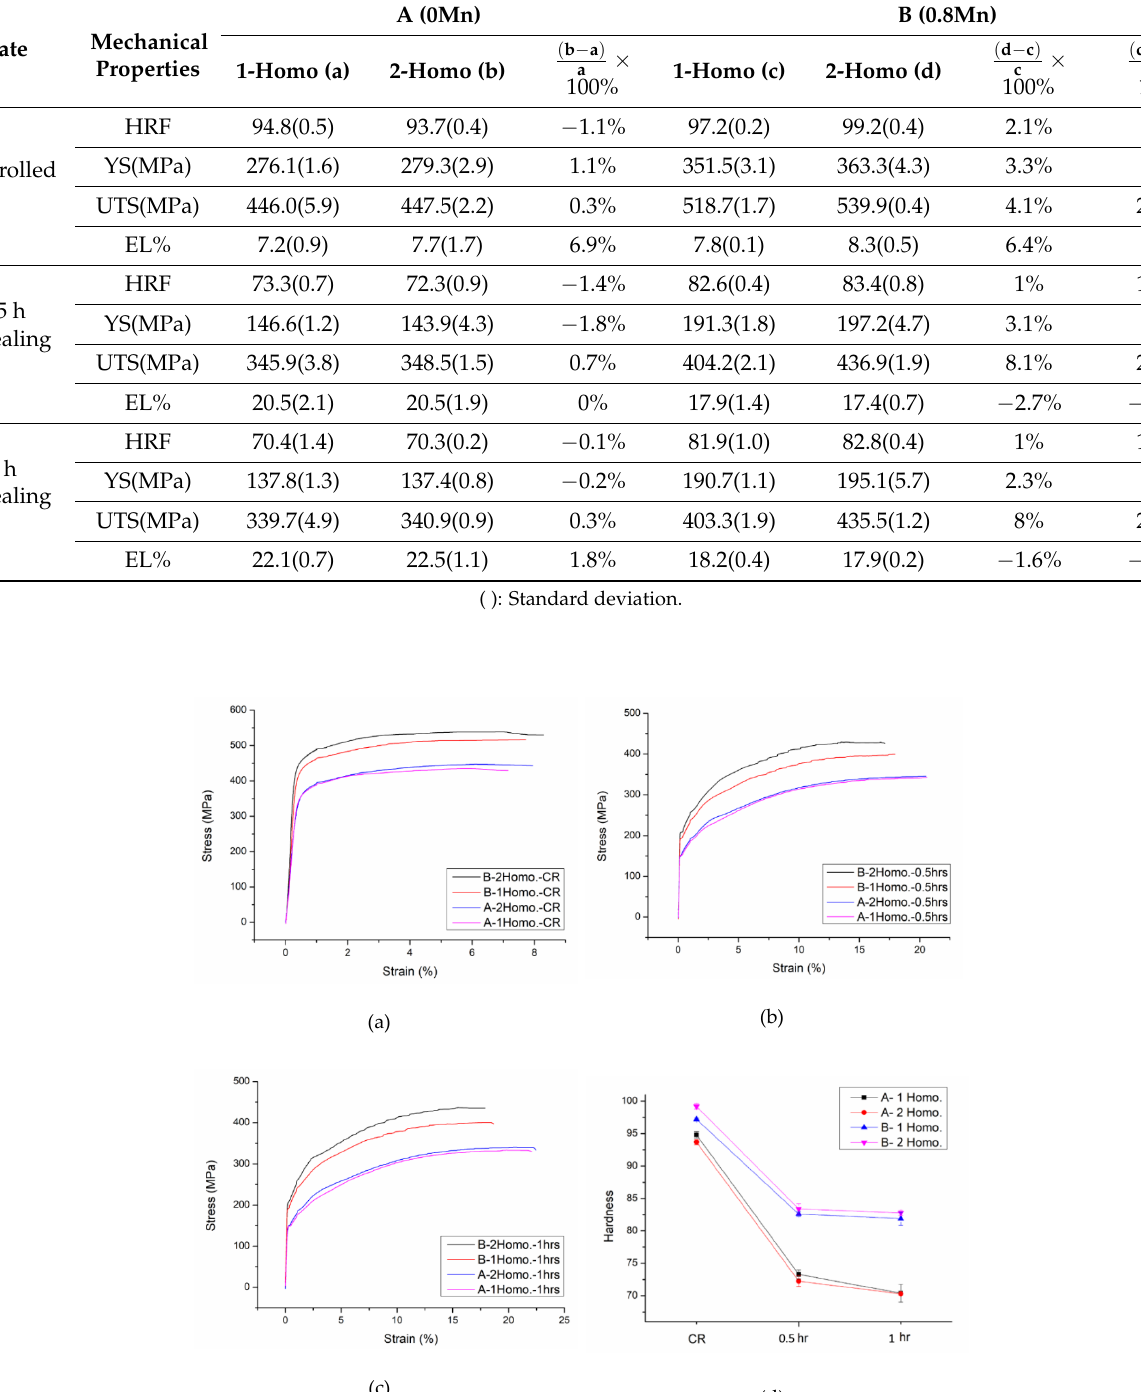
Table 2. A summary table of the test results of the mechanical properties of aluminum–magnesium alloys in various processes.